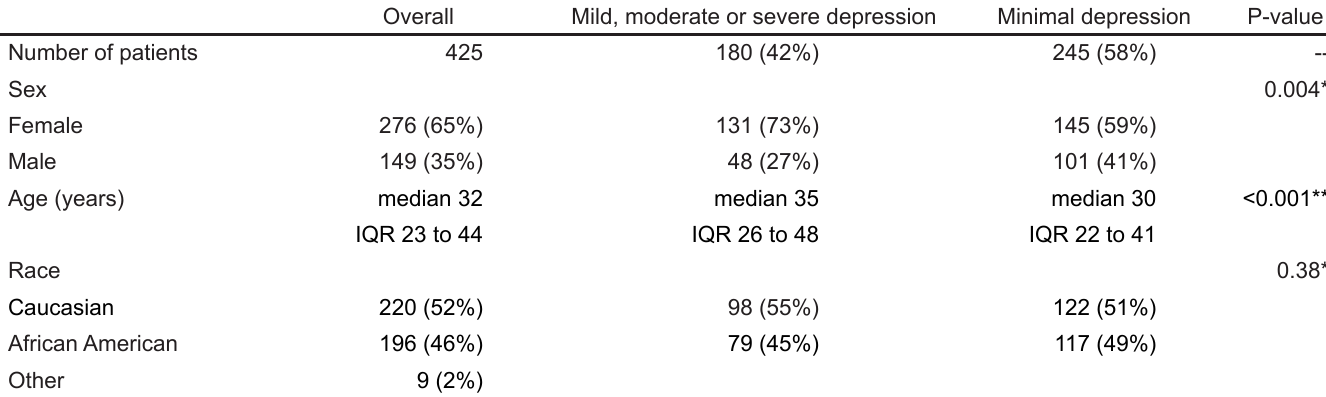
Table 1. Comparison of sample population demographics by severity of depression.